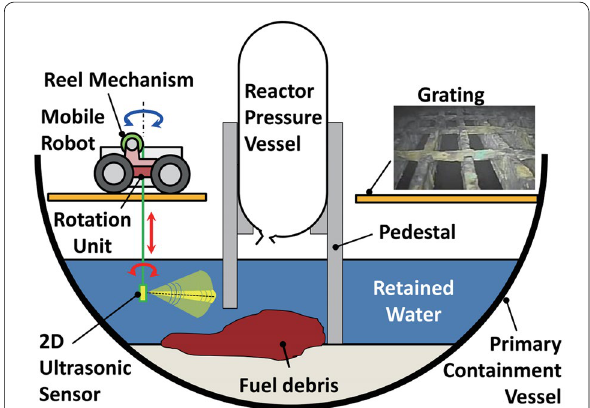
Fig. 1 Overview of the proposed robotic